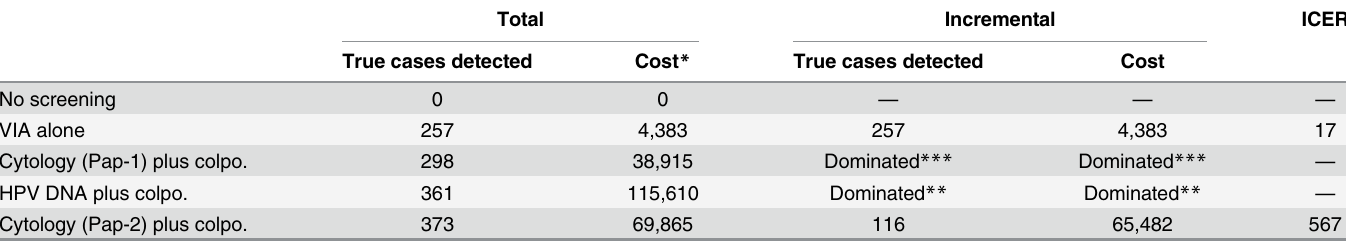
Table 5. Incremental cost-effectiveness analysis (Functional Limit scenario).